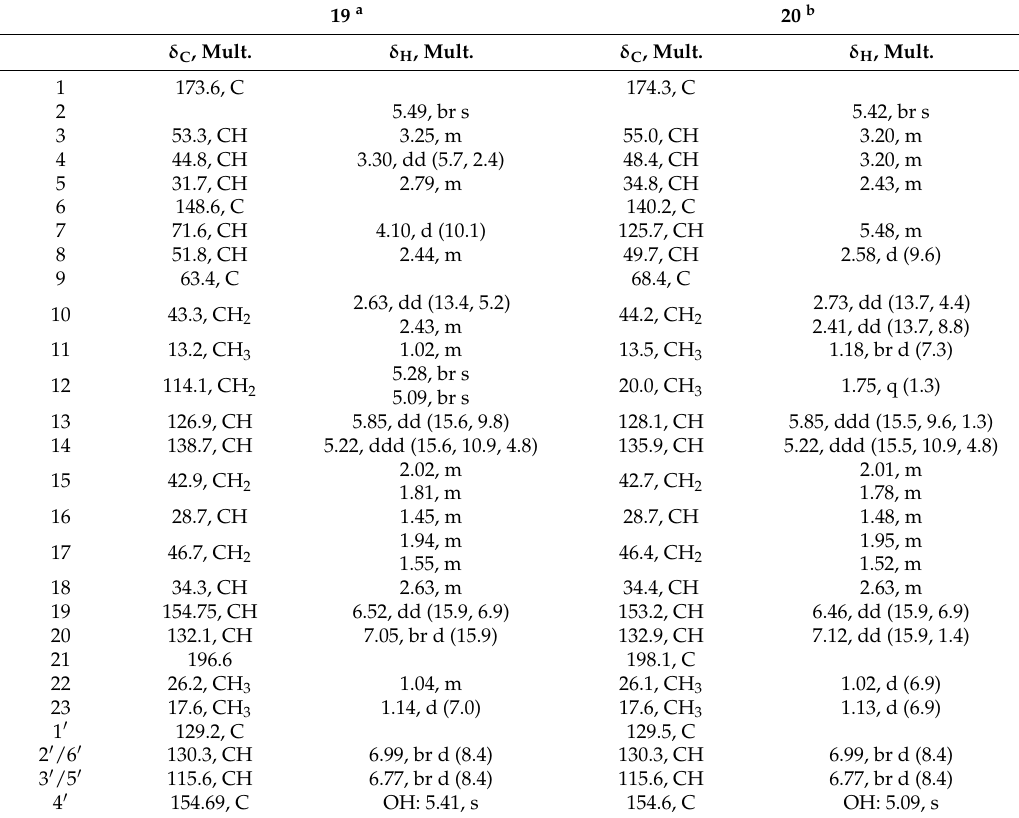
Table 1. Nuclear magnetic resonance (NMR) data of new metabolites 18 – 20 in CHCl 3 - d . 19 a 20 b δ C , Mult. δ H , Mult. δ C , Mult. δ H ,